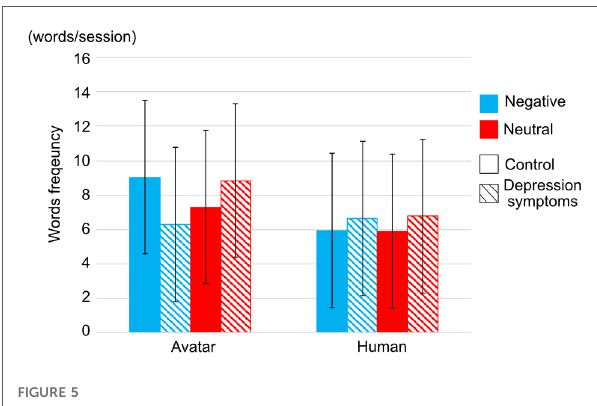
FIGURE 5 Word frequency in each interviewer. Striped pattern boxes indicate the data of the depressed symptoms group, and solid boxes are the control group. Error bars indicate 95%